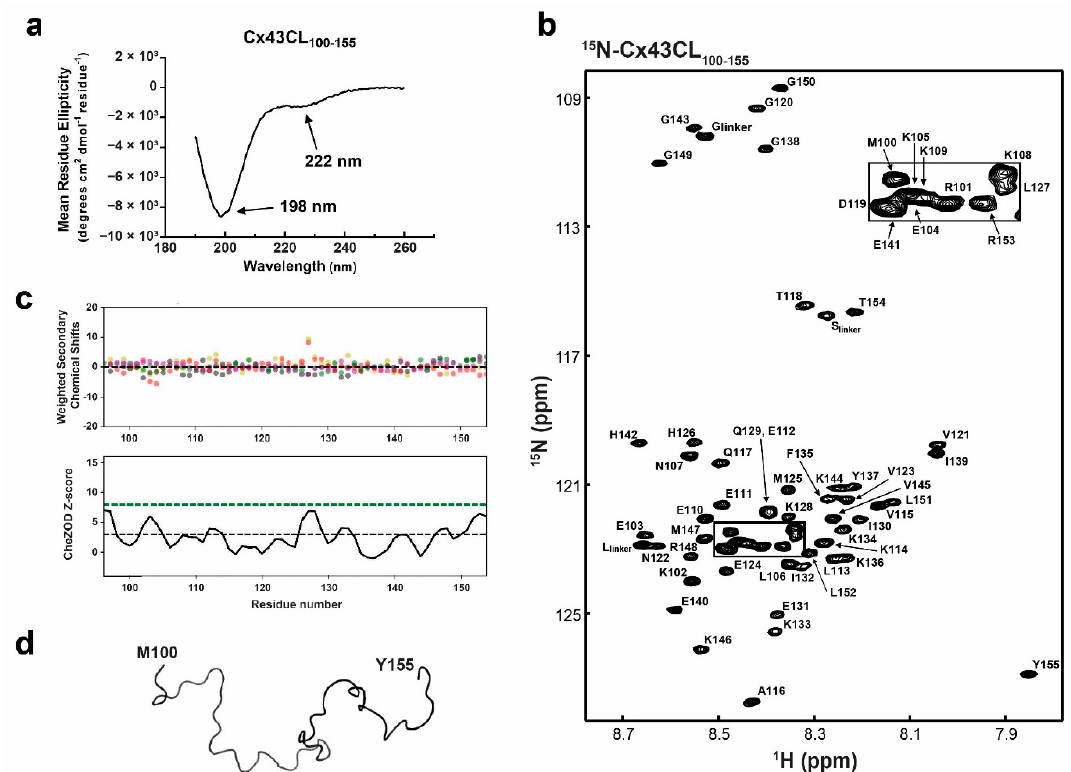
Figure 1. Structural analysis of the Cx43CL 100-155 domain. ( a ) Circular dichroism (CD) spectrum of Cx43CL 100-155 in 1× PBS at pH 5.8. Peaks at 198 and 222 nm, typical of random coiled and α -helix containing proteins, respectively, have been labeled. ( b ) 15 N-HSQC spectrum of 15 N-labeled Cx43CL 100-155 in 1× PBS (pH 5.8, 7 °C). Each residue (but proline) has been labeled. ( c ) Top panel: weighted difference between observed and predicted shifts, shown with salmon, grey, green, beige, and purple dots for C α , C β , H α , H β , and N respectively. Bottom panel: Z score represented as a black line drawn from the score of each residues. Threshold lines for totally disordered Z < 3 (black dashes) and ordered Z > 8 (green dashes) are represented. ( d ) Backbone trace of the lowest energy Cx43CL 100-155 NMR structure.